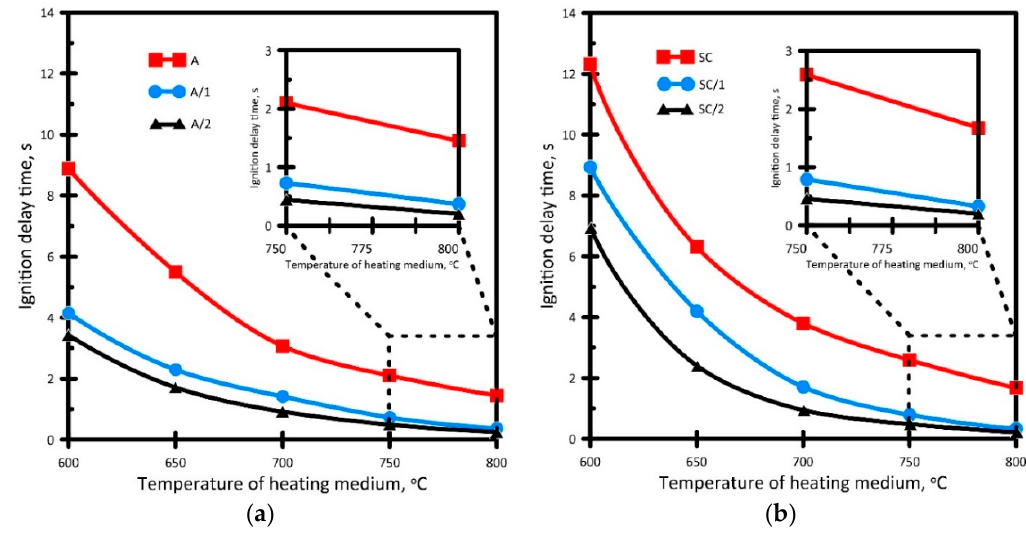
Figure 3. The dependencies of the ignition delay time on the temperature of heating medium for the samples of anthracite ( a ) and semi ‐ coke ( b ).